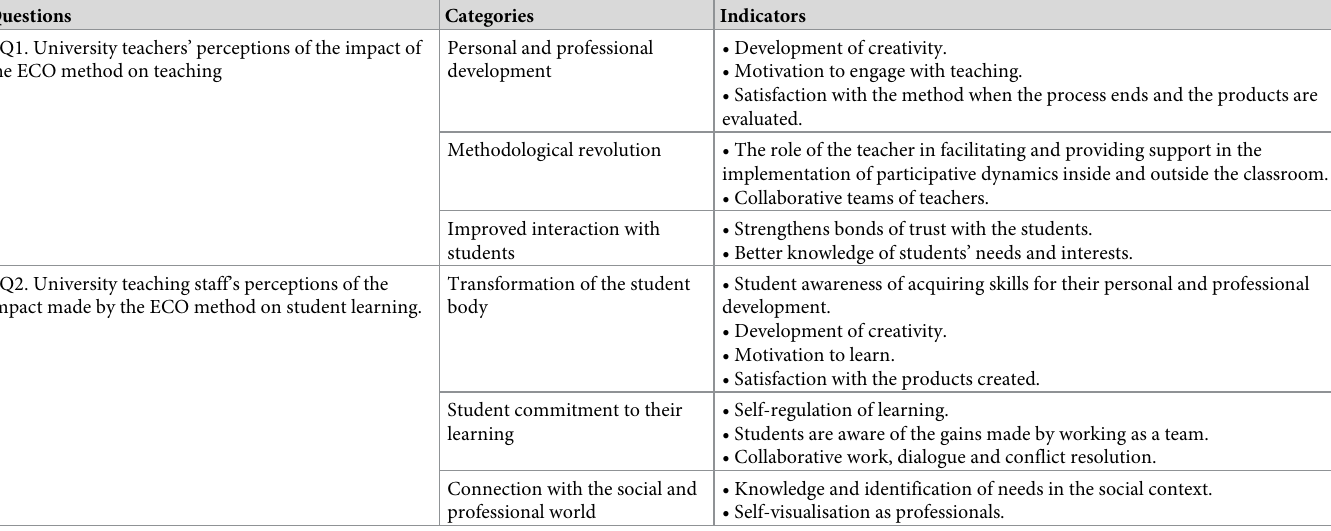
Table 1. Categories